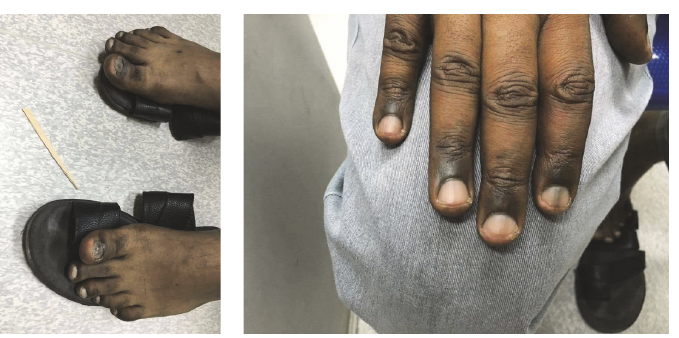
Figure 1: Marked hyperpigmentation over the knuckle pads (interphalangeal joints) and (periungual areas) of the hands and feet.